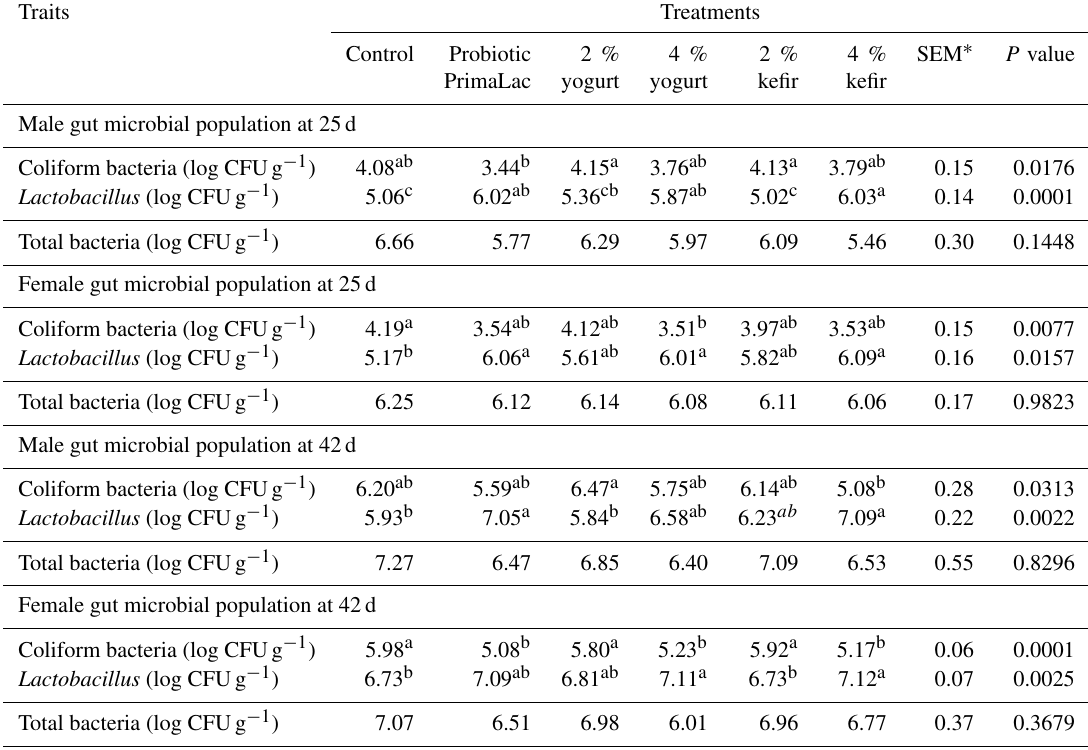
Table 5. The effects of using kefir, yogurt, and probiotic on gut microbial population in male and female broiler chickens at 25 and 42d. Traits Treatments Control Probiotic 2 % 4 % 2 % SEM ∗ P value PrimaLac yogurt yogurt kefir